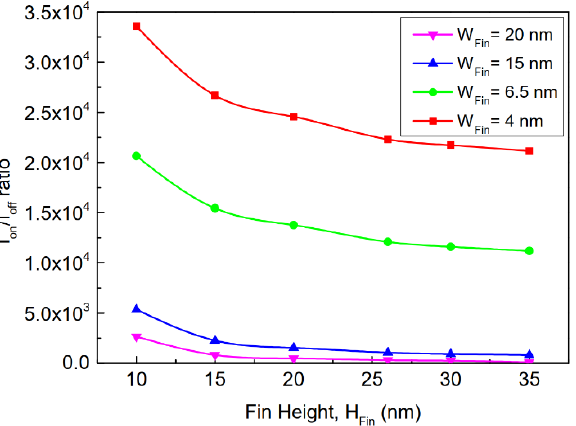
Figure 11. Behavior of the current ratio I on / I off as a function of fin height for FinFET devices with different values of the fin width at V ds = 0.8 V.